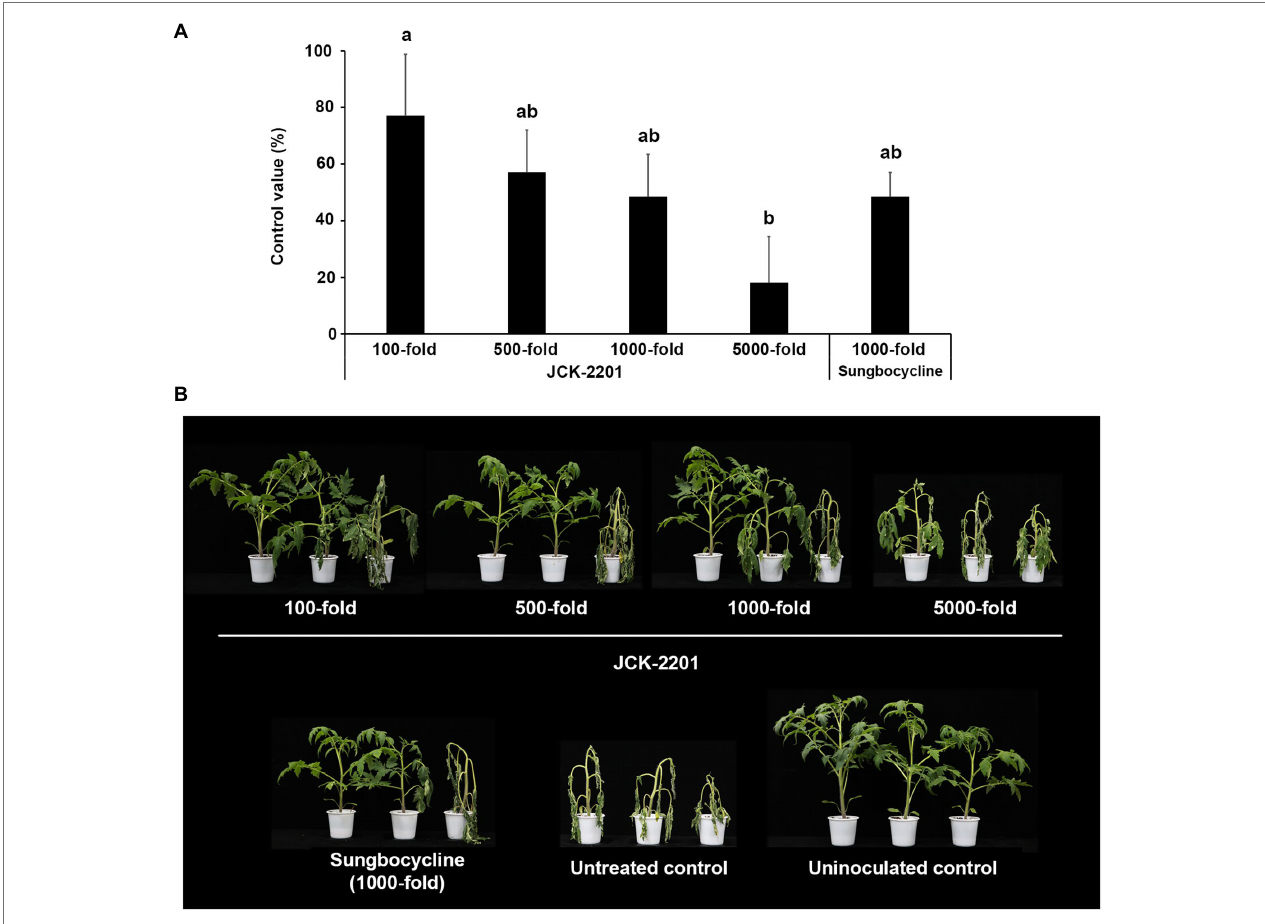
FIGURE 1 | Disease control efficacy of K. pneumoniae JCK-2201 culture supernatant on tomato bacterial wilt caused by R. solanacearum . (A) Control value was investigated 7 days after pathogen inoculation. The data show the means ± SD ( n = 3). Lower-case letters indicate statistically significant differences as compared to untreated control plants ( p < 0.05) according to Tukey’s HSD test. Error bars indicate the SDs. (B) Representative photographs of tomato seedlings at 7 days after inoculation of R. solanacearum by soil drench. As a positive control, plants were treated with